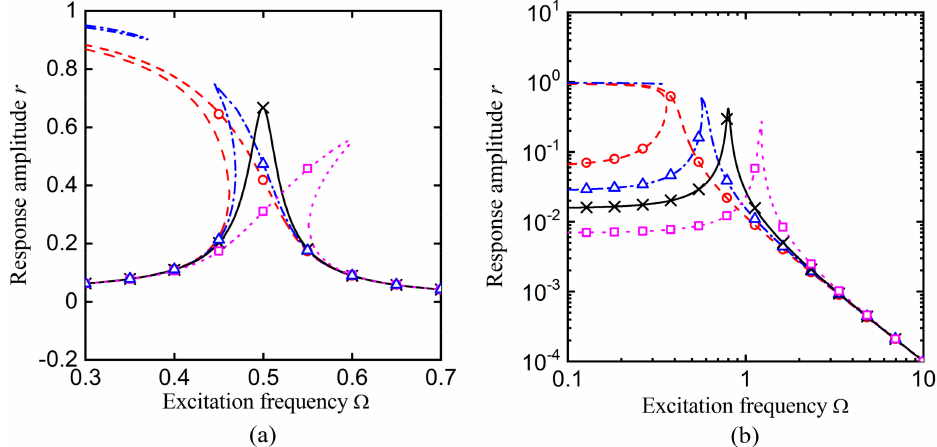
Figure 6. Frequency response curves of systems with ( a ) a fixed product αβ and ( b ) a varying product αβ with ξ = 0.015, F 0 = 0.01. The dashed, dash–dot, solid, and dotted lines in ( a ) are for ( α , β ) = ( − 1.5, 0.5 ) , ( − 1.25, 0.6 ) , ( − 1, 0.75 ) , and ( − 0.5, 1.5 ) , respectively, while in ( b ), the lines are for ( α , β ) = ( − 1.2, 0.7 ) , ( − 1.6, 0.4 ) , ( − 1, 0.36 ) , and ( 0.2, 2.2 ) , respectively. Circles, triangles, crosses, and squares denote the corresponding numerical